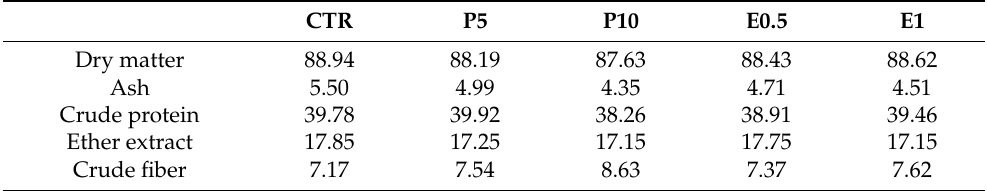
Table 1. Chemical composition (% as feed) of the experimental diets provided to gilthead